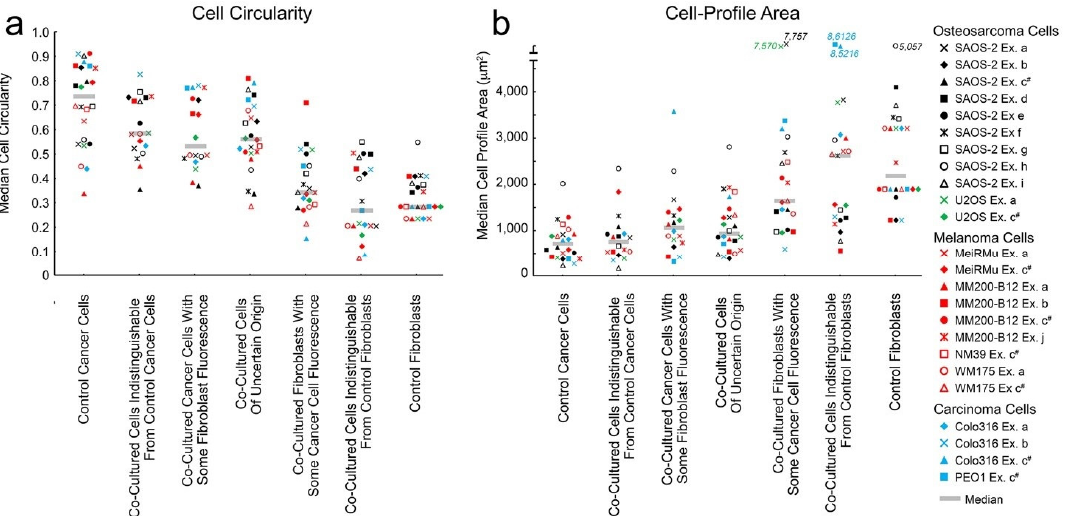
Figure 4. Median cell circularity ( a ) and cell-profile area ( b ) measurements of co-cultured cells grouped according to classification by Cartesian plot, as well as of control cancer cells and fibroblasts, across all 24 co-cultures studied in 10 separate experiments (Ex.). While median values for individual co-cultures are shown, medians across all experiments are also marked within each group by horizontal transparent grey lines. Symbols for co-cultures with SAOS-2 are in black, to aid visual separation from remaining co-cultures with other cancer cell lines. Fibroblasts were labelled with DiD in all experiments. Cancer cells were labelled with DiO, with exception of experiment ‘i’ where SAOS-2 expressed GFP, and also in experiment ‘c’, which is marked c # in the legend and where the orientation of fluorescent labels was swapped. Statistical comparison between all groups shown are provided in Tables S17–S20 in the Supplementary Materials. ( a ) Control cancer cells cultured in isolation, had higher cell circularity compared with similarly isolated control fibroblasts ( p < 0.0001, Wilcoxon signed-rank test). This difference was retained in co-culture, as determined by the com- parison of co-cultured cells with fluorescence indistinguishable from either control cancer cells, or control fibroblasts ( p < 0.0001, Wilcoxon signed-rank test). While there was no statistically significant difference in cell circularity between control cancer cells and co-cultured cells with fluorescence indis- tinguishable from control cancer cells, co-cultured cancer cells with some fibroblast fluorescence were less circular compared with control cancer cells ( p < 0.001, Wilcoxon signed-rank test). Co-cultured cancer cells with some fibroblast fluorescence did have generally lower cell circularity compared with co-cultured cells indistinguishable from control cancer cells, but this did not reach statistical significance. Control fibroblasts cultured in isolation did not differ significantly in cell-circularity compared with co-cultured cells with fluorescence indistinguishable from control fibroblasts, but co- cultured cells with fluorescence indistinguishable from control fibroblasts were less circular compared with co-cultured fibroblasts with some cancer cell fluorescence ( p < 0.03, Wilcoxon signed-rank test). Co-cultured cells of uncertain origin were more circular compared with co-cultured cells identified as fibroblasts either with or without fluorescence from cancer cells, as well as compared against control fibroblast cultures ( p < 0.0001); ( b ) control cancer cells cultured in isolation, had lower cell-profile area compared with similarly isolated control fibroblasts ( p < 0.0001, Wilcoxon signed-rank test). This difference was retained in co-culture, as determined by the comparison of co-cultured cells with fluorescence indistinguishable from either control cancer cells, or control fibroblasts ( p < 0.0001, Wilcoxon signed-rank test). While there was no statistically significant difference in cell-profile area between control cancer cells and co-cultured cells with fluorescence indistinguishable from control cancer cells, co-cultured cancer cells with some fibroblast fluorescence had higher cell-profile area compared with both control cancer cells ( p < 0.0001, Wilcoxon signed-rank test) and co-cultured cells with fluorescence indistinguishable from control cancer cells ( p < 0.042, Wilcoxon signed-rank